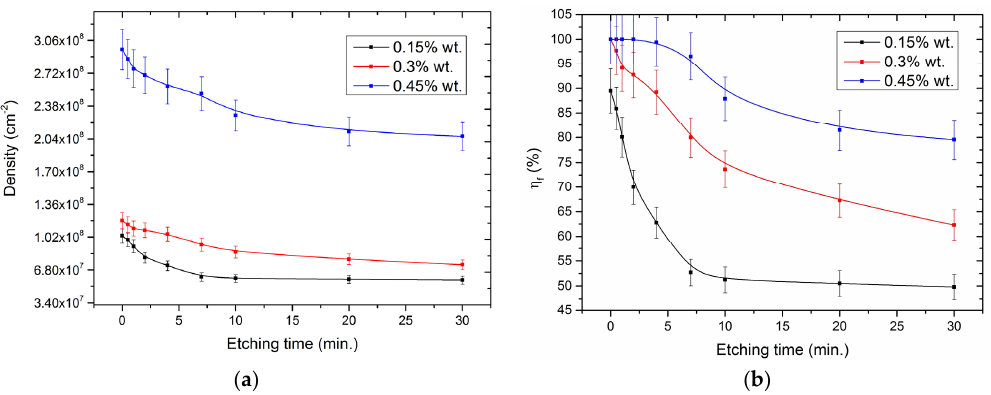
Figure 4. Nucleation particle density ( a ) and relative area of the film coating ( b ) for pattern area with diamond films depending on etching time.